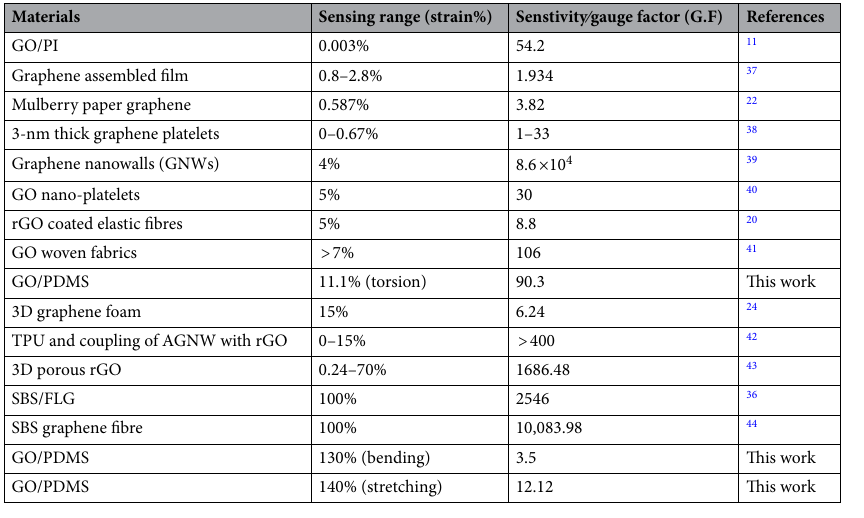
Table 2. Comparison between PDMS/rGO/PDMS structure with previously reported Graphene strain sensors. This sensor shows very good results for stretching, bending and torsion when considering both sensitivity and sensing